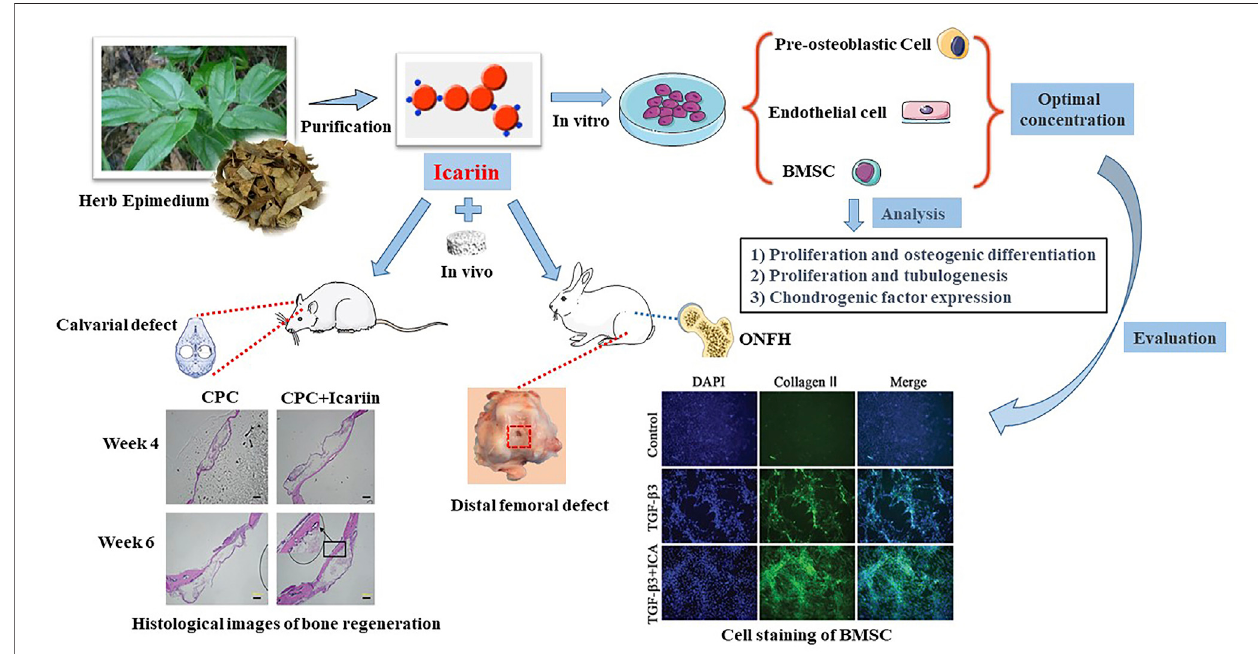
FIGURE1| Illustration oficariin:theorigin,molecular structure,andbiomedical researches.IcariinisobtainedfromtheleavesofEpimediumherb.Asawidelyused TCM, icariin demonstrates extensive therapeutic capacities such as osteogenic differentiation, tubulogenesis, and chondrogenic factor expression. Calvarial defect, distal femoral defect and ONFH mice/rabbits are commonly used animal